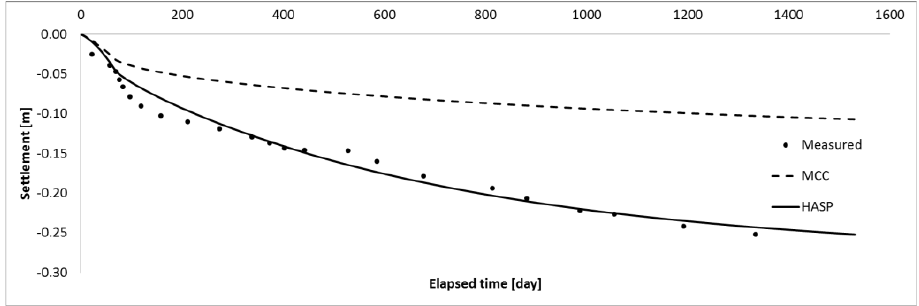
Figure 14. Comparison of settlement-time curves for Embankment B — Point A.